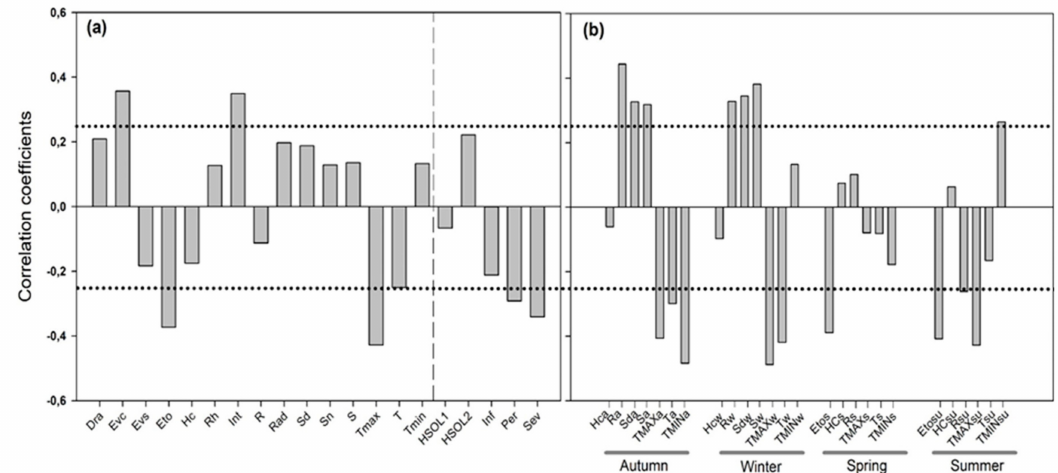
Figure 4. Spearman´s correlation coe ffi cients obtained by comparing defoliation ( proxi NBR) and hydrological variables for Pinus pinaster forests a ff ected by the defoliation process in Sierra de Baza (Andalusia-Granada). In ( a ), the variables were then computed for the hydrological year (01 October to September 30, inclusive), and ( b ) mean values were then computed at the seasonal scale. At the right of dashed line, hydrological variables related to the soil water content. Dotted lines are significant values (p < 0.05). See Table S1 for a list of the